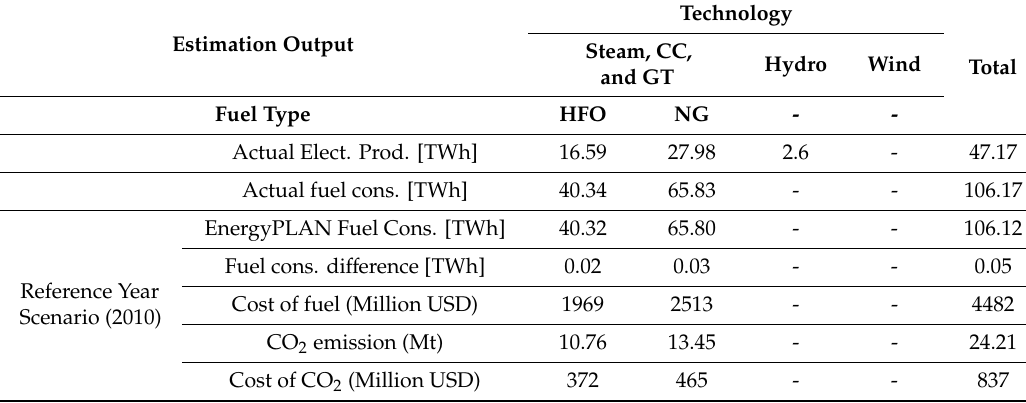
Table 11. Actual electricity production and the EnergyPLAN estimated fuel consumption, cost of fuel, CO 2 emission, and CO 2 cost of the SEPS in